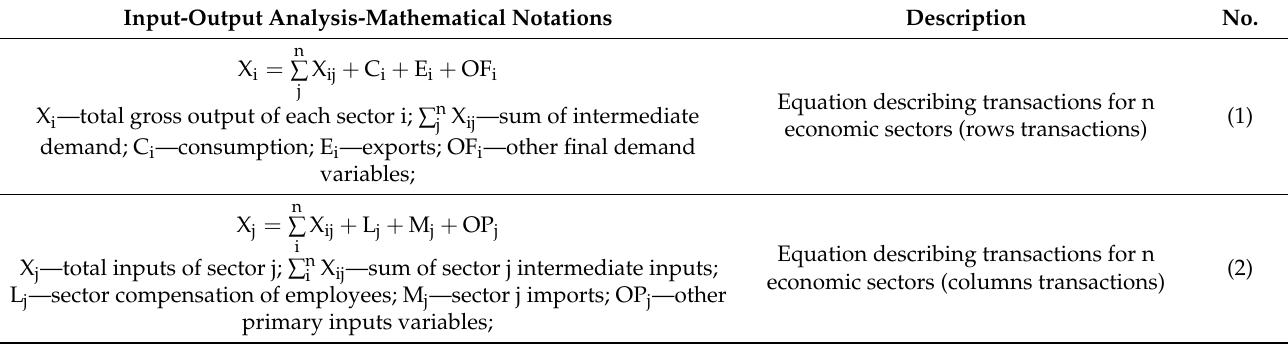
Table 1. Input–output analysis, main steps